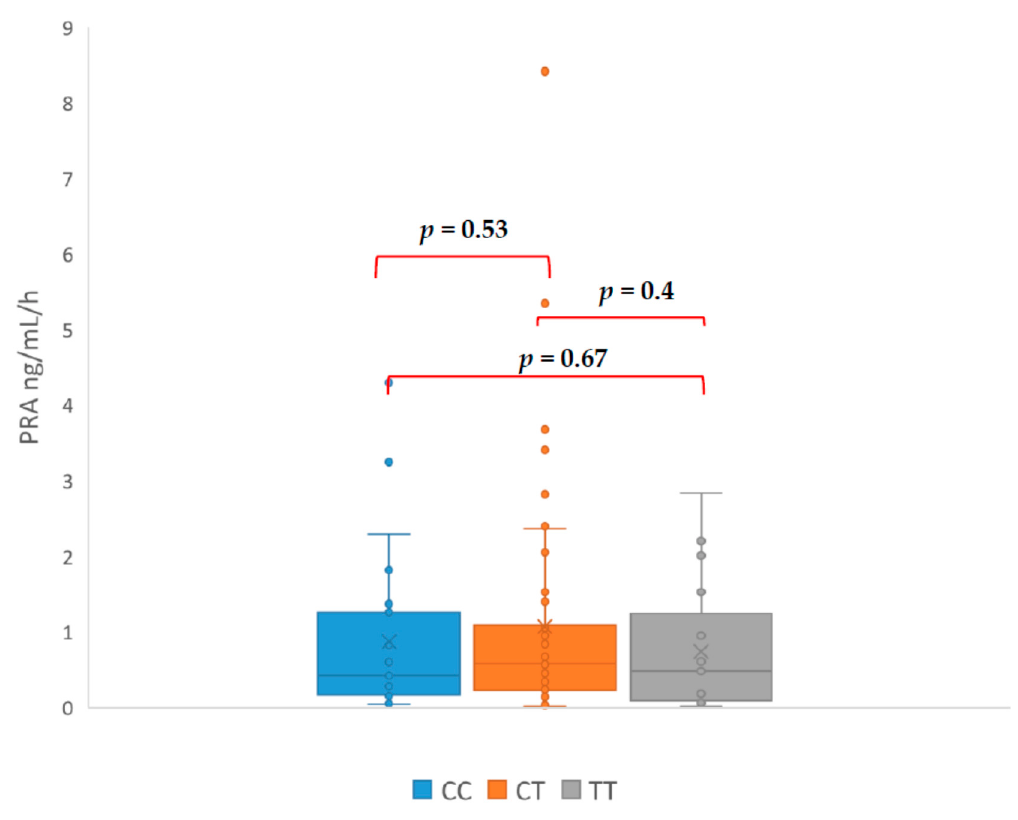
Figure 4. Di ff erences in plasma renin activity (PRA—plasma renin Figure 4. Differences in plasma renin activity (PRA—plasma renin activity).